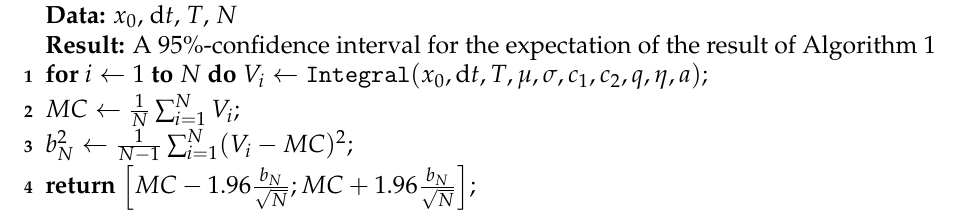
Algorithm 2: 95%-confidence interval for the expectation of an Itô’s integral using Monte Carlo’s